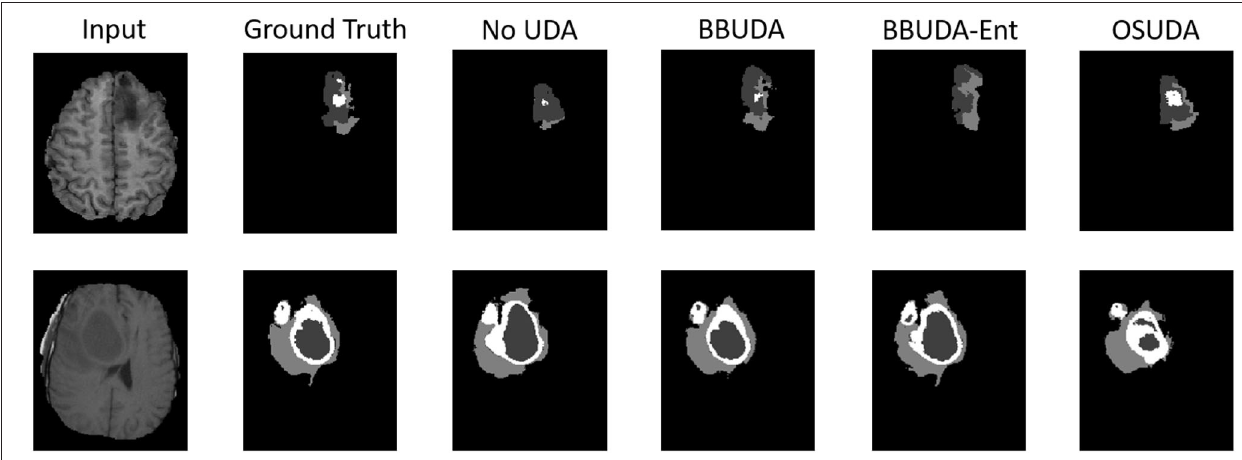
FIGURE 4 | Examples of our segmentation results from T1-weighted MRI with different methods in the T2 to T1 UDA task. In addition, BBUDA-Ent represents an ablation study of the entropy minimization. We use white, dark gray, and gray color to indicate the CoreT, EnhT, and ED, respectively. OIt is of note that OSUDA (Liu et al., 2021k ) with the white-box source model for adaptation is considered an “upper bound.”